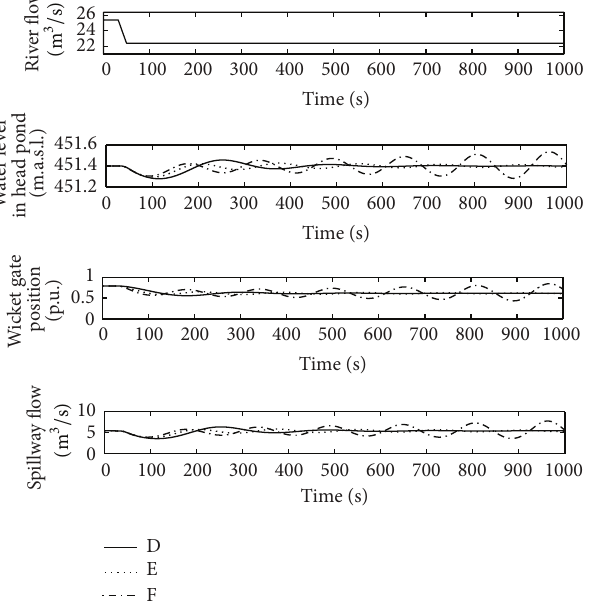
Figure 14: River flow, wicket gates position, water level in the head pond, and spillway flow, in flood operation (points D, E, and